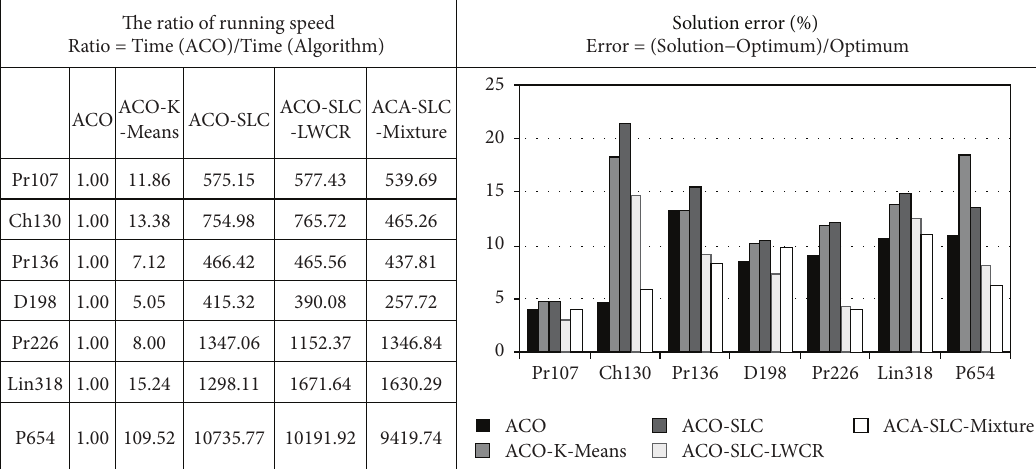
Figure 5: The performance comparison with five algorithms. The figure shows that ACO-SLC algorithm, ACO-SLC, ACO-SLC-LWCR, and ACO-SLC-Mixture are faster than ACO by 415 ∼ 10736 , 390 ∼ 10192 , and 257–9419 of factors, respectively! However, some solutions of ACO-K-Means and ACO-SLC have low quality. ACO-SLC-Mixture can process mixture distribution and its inaccuracy ratio is less than ACO in most cases and is bigger than ACO by 2% at most. It should be noted that under the condition where the data set holds feature of local clustering significantly, the quality of solution is